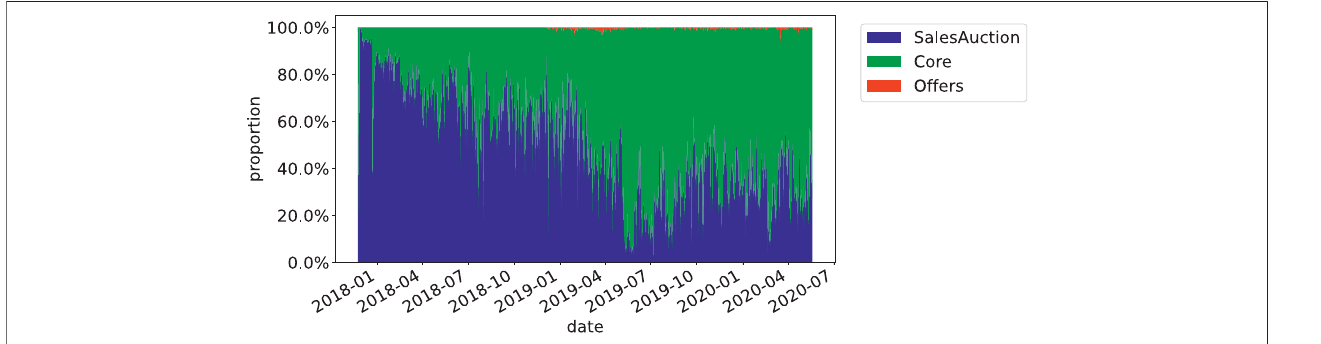
FIGURE 5 | The change in proportion of three methods to transfer the kitties.